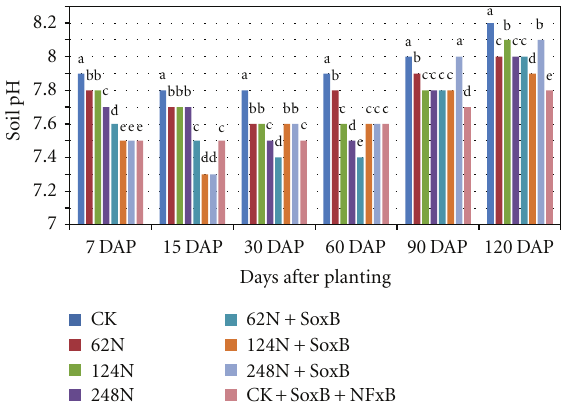
Figure 2: Change in soil pH in onion rhizosphere soil over 120 days after planting (DAP). Means followed by same letters, by each sampling date, are not significantly di ff erent as per Duncan’s Multiple Range test at P ≤ 0 .